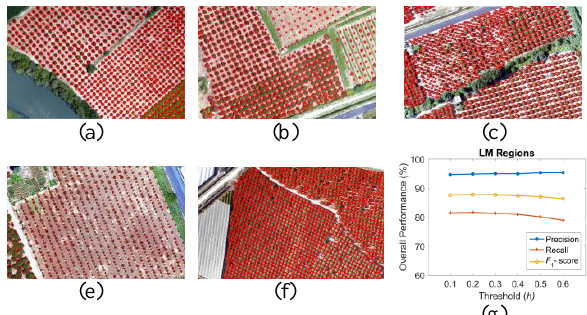
Figure 4. (a-f) The reference data (in red color) are generated by manual on-screen digitizing, and (g) performance results computed for different h thresholds.